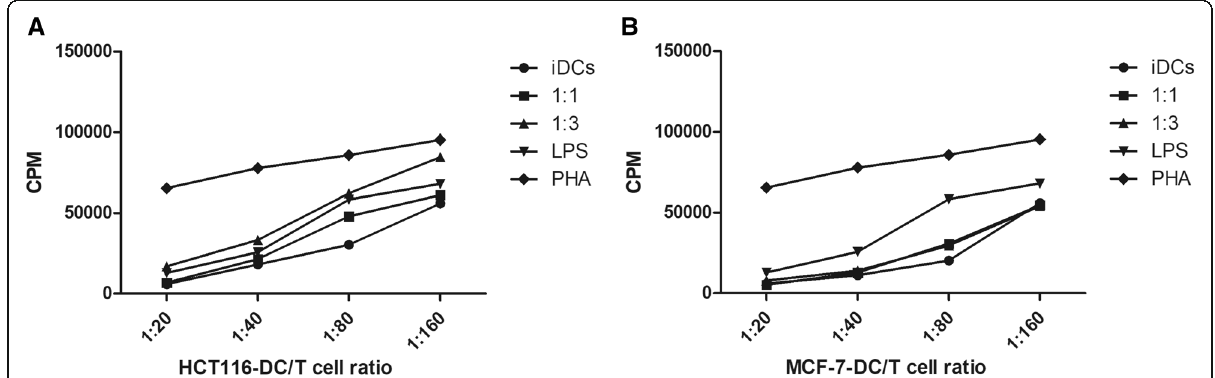
Fig. 7 Increase of the allogeneic T cell proliferation capacity of HCT 116 tumor lysate pulsed dendritic cells. iDCs were pulsed with a HCT116 TLY and b MCF-7 TLY at 1:1 and 1:3 ratios. PHA was used as a positive control. The data are given in mean±SEM of three experiments comprising three different healthy donors. iDCs, immature dendritic cells; TLY, tumor lysate; LPS, Lipopolysaccharide; CPM, count per minute; PHA,